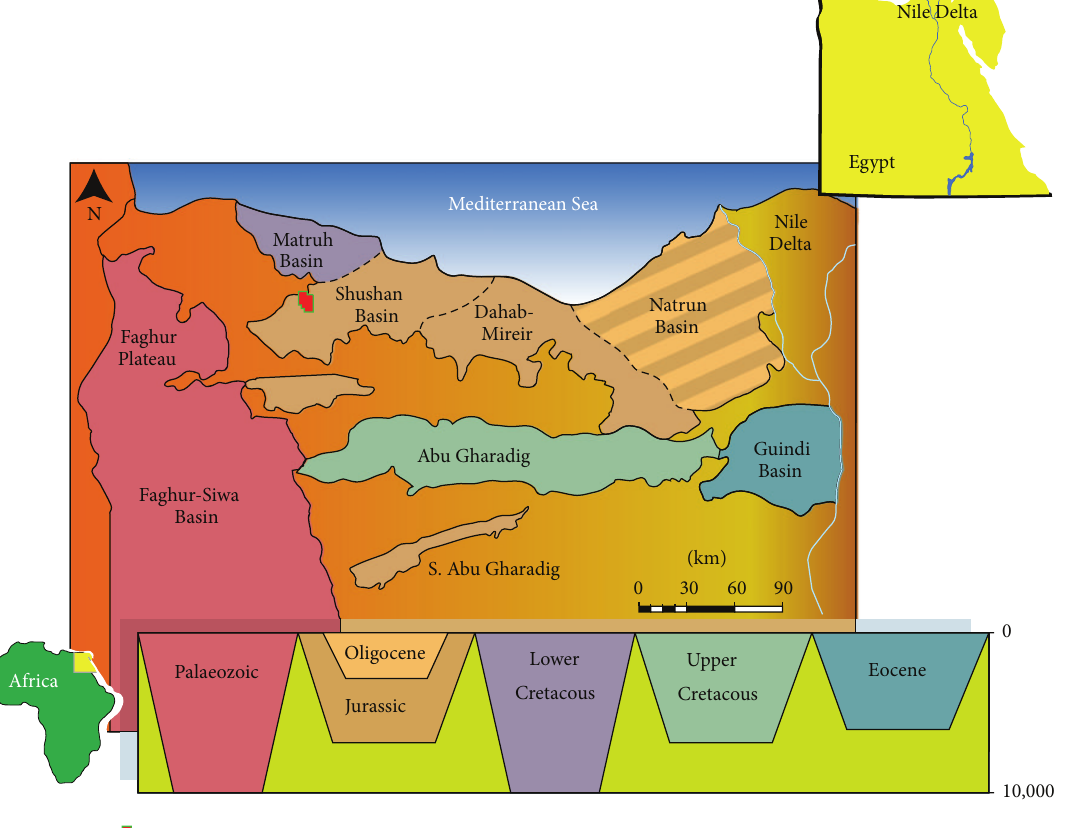
Figure 1: Location map of the Shushan Basin